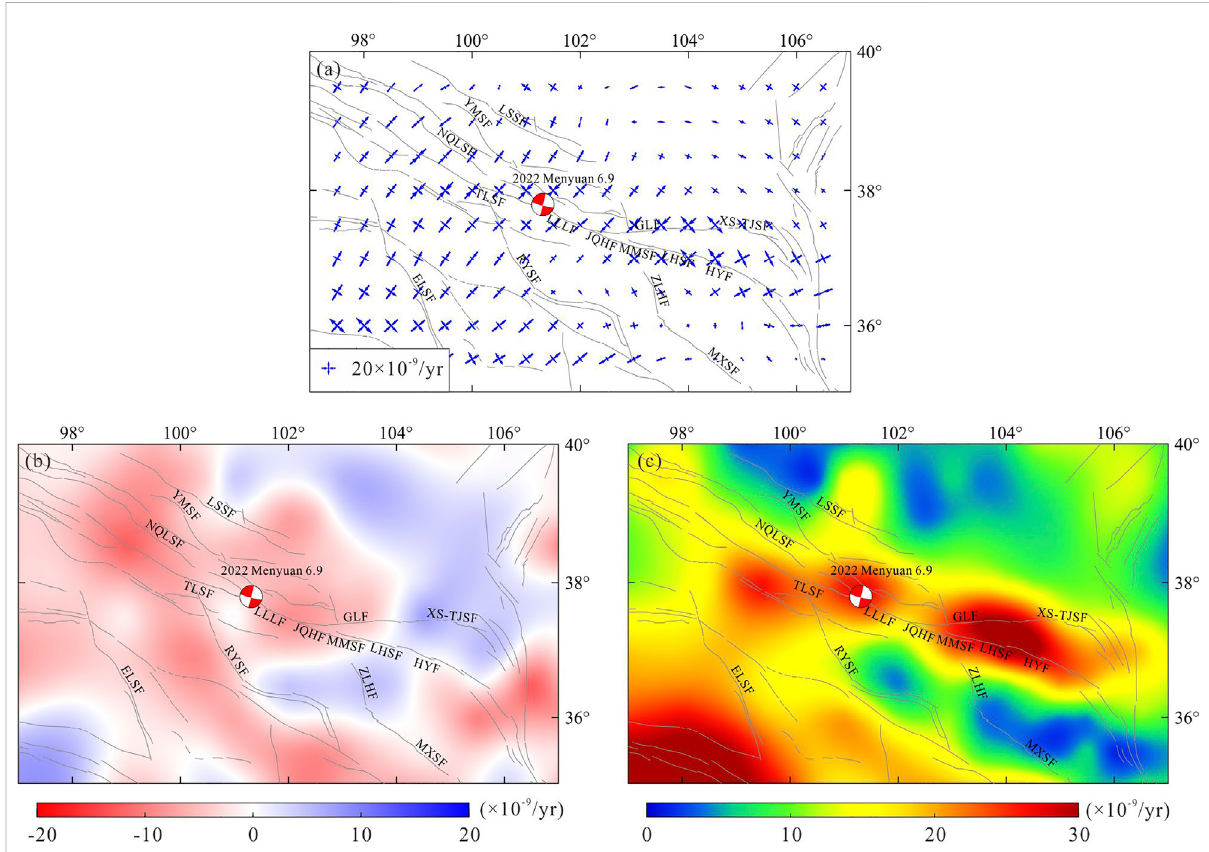
FIGURE 4 Principal strain rate (A) dilatation rate (B) andmaximumshear strainrate (C) ofthestudy area. LSSF:Longshoushanfault; YMSF: Yumushan fault; NQLSF: Northern Qilian Shan fault; TLSF: Tuolaishan fault; LLLF: Lenglongling fault; JQHF: Jinqianghe fault; MMSF: Maomaoshan fault;